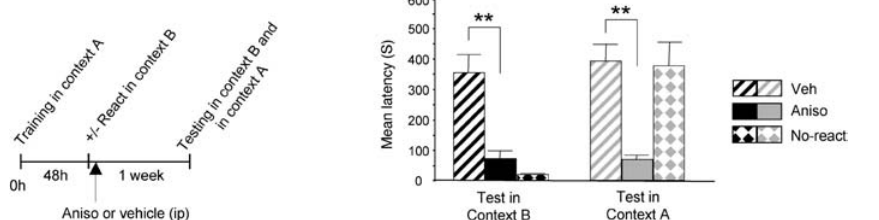
Figure 2. Both the Association Formed between New and Reactivated Information and the Reactivated Original IA Memory Are Disrupted by Systemic Inhibition of Protein Synthesis Latency to enter the shock chamber was taken as a measure of memory retention. Systemic anisomycin injection (Aniso, n ¼ 8) immediately after visual CS reactivation in context B induced amnesia for both context A and B compared with vehicle injection (Veh, n ¼ 8) (** ¼ p , 0.01). Anisomycin did not affect memory of context A in rats that did not receive reactivation ( n ¼ 8, No-react). DOI: 10.1371/journal.pbio.0030293.g002 PLoS Biology |